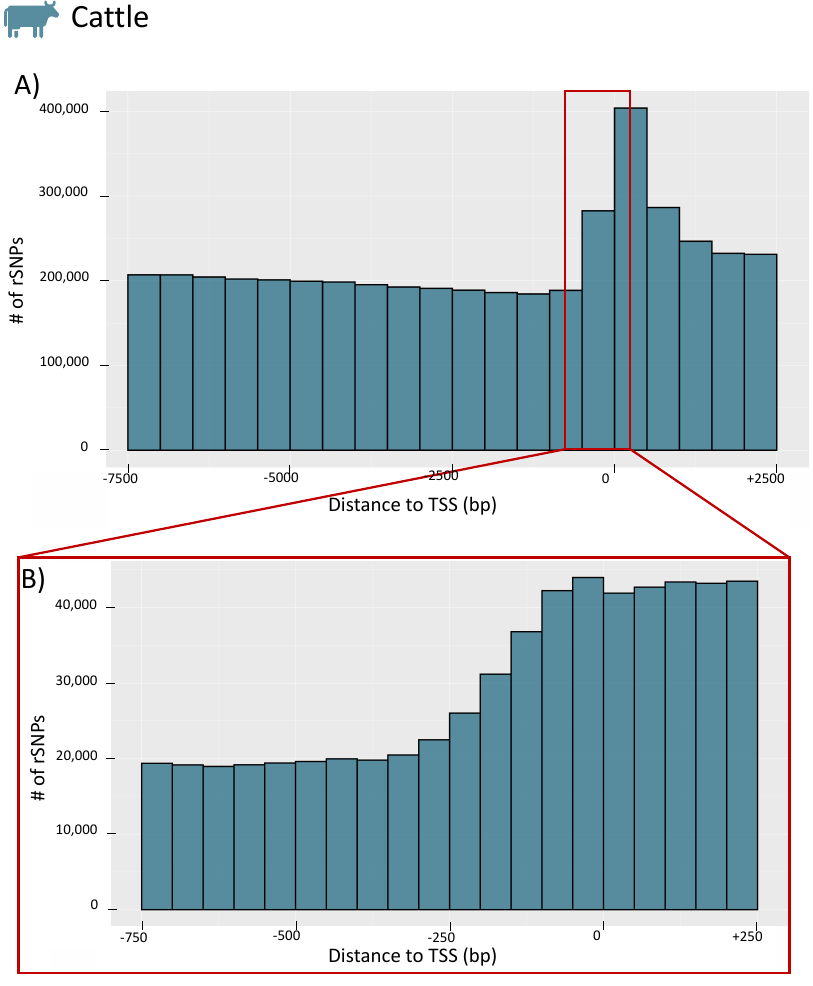
Figure 8. Distribution of the distances between rSNPs and the TSS of cattle. ( A ) The counts for the whole promoter region ( − 7.5 kb to +2.5 kb) in 500 bp intervals. The enlargement in ( B ) shows the proximal promoter region ( − 750 bp to +250 bp) in 50 bp